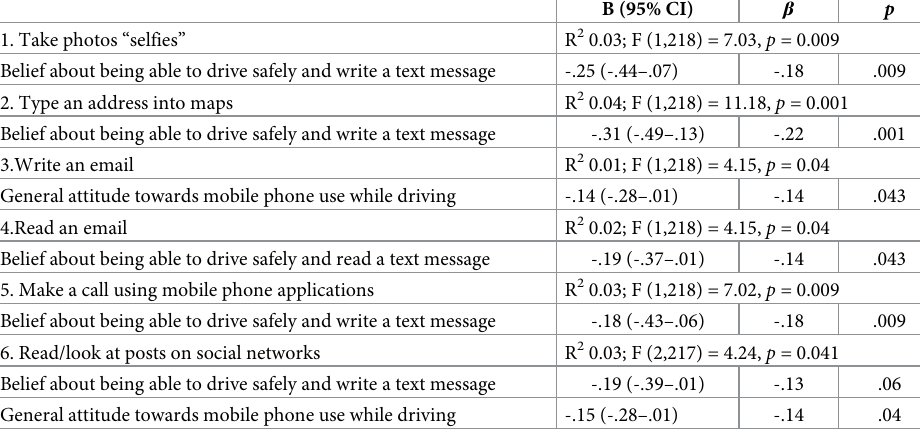
Table 4. Factors related to different types of mobile phone applications use while driving (N =